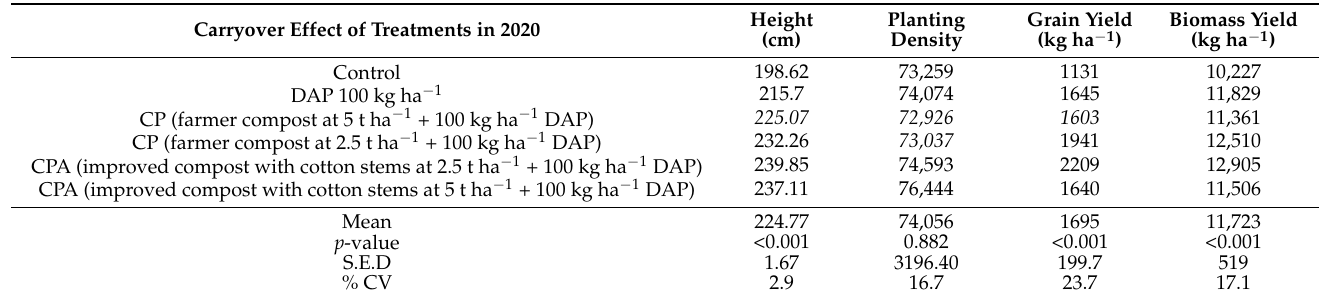
Table 5. Carryover effect of compost application on